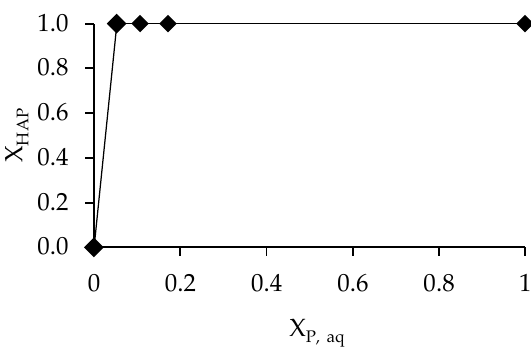
Figure 13. The Roozeboom diagram for the JBM–HAP solid solution series.